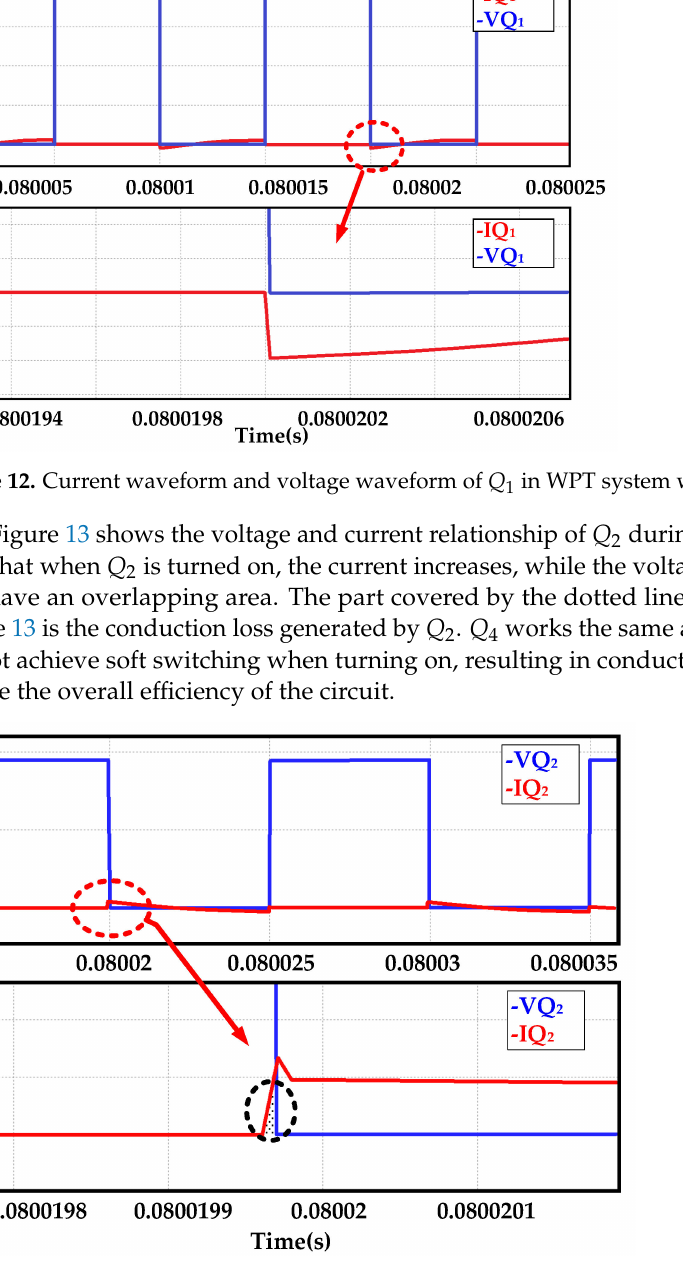
Figure 13. Current waveform and voltage waveform of Q 2 in WPT system without